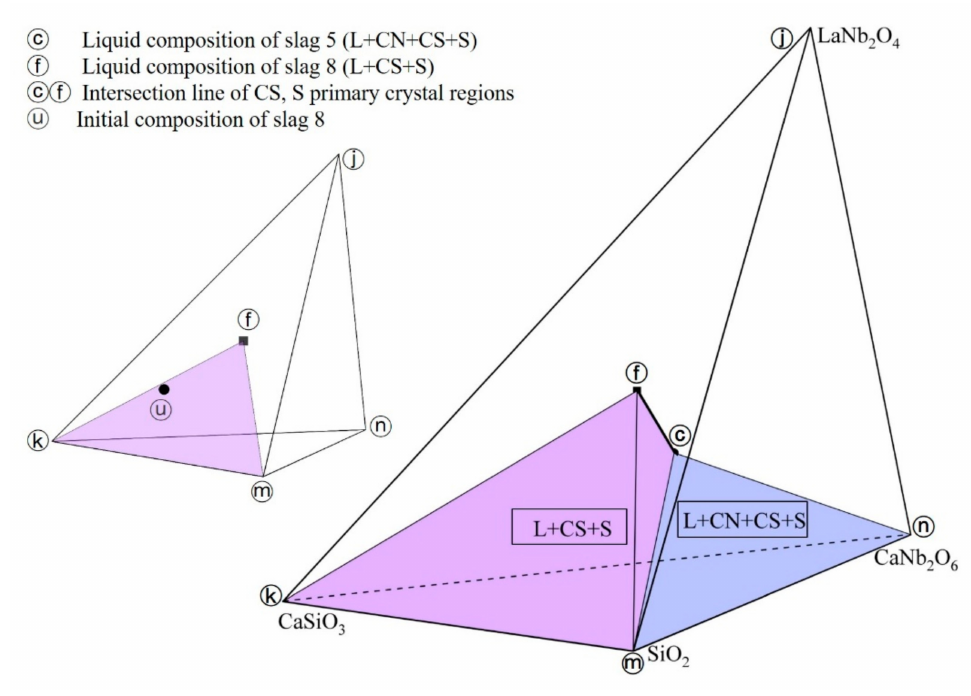
Figure 7. Intersection line of CS, S primary crystal